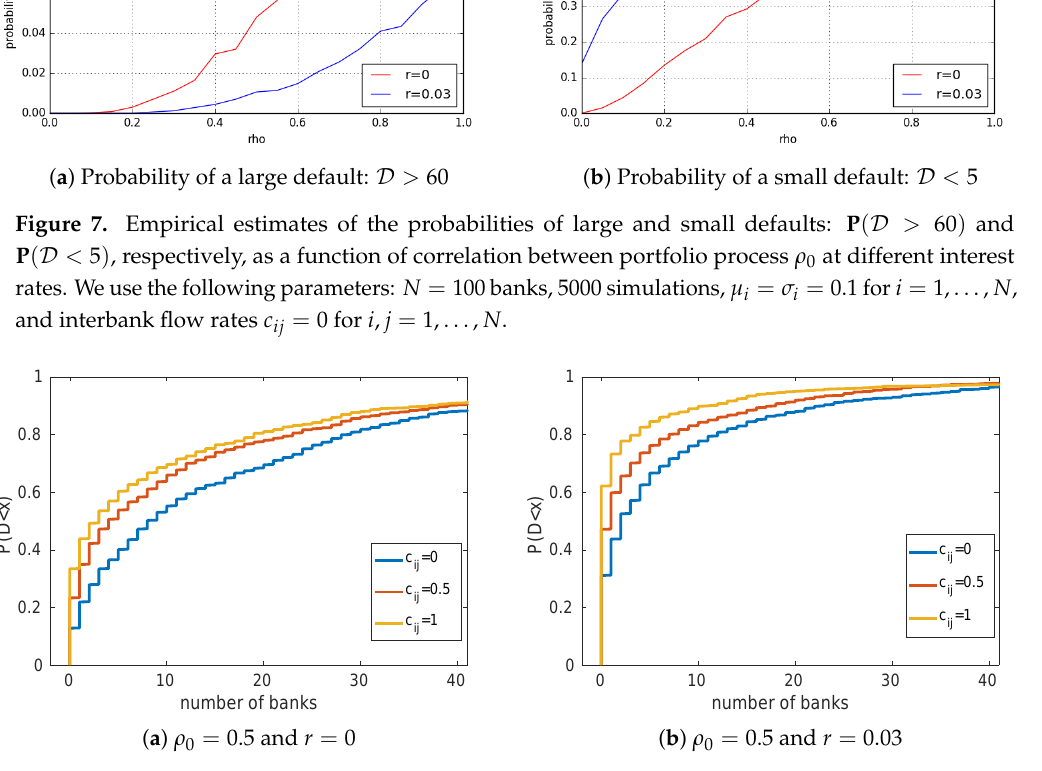
Figure 8. Empirical CDF of the number D of banks in default. We use the following parameters: N = 100 banks, 1000 simulations, µ i = σ i = 0.1 for i = 1, . . . , N , and constant interbank flows c ij = a for i , j = 1, . . . , N , where a ∈ { 0,0.5,1 }